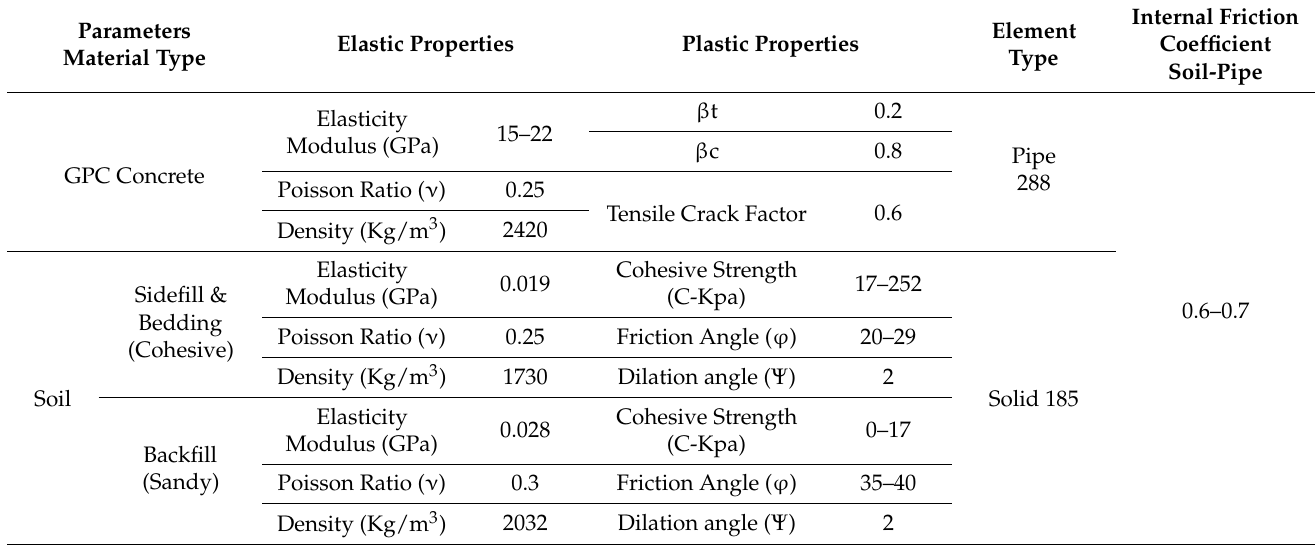
Table 6. Material properties of soil and GPC pipe.